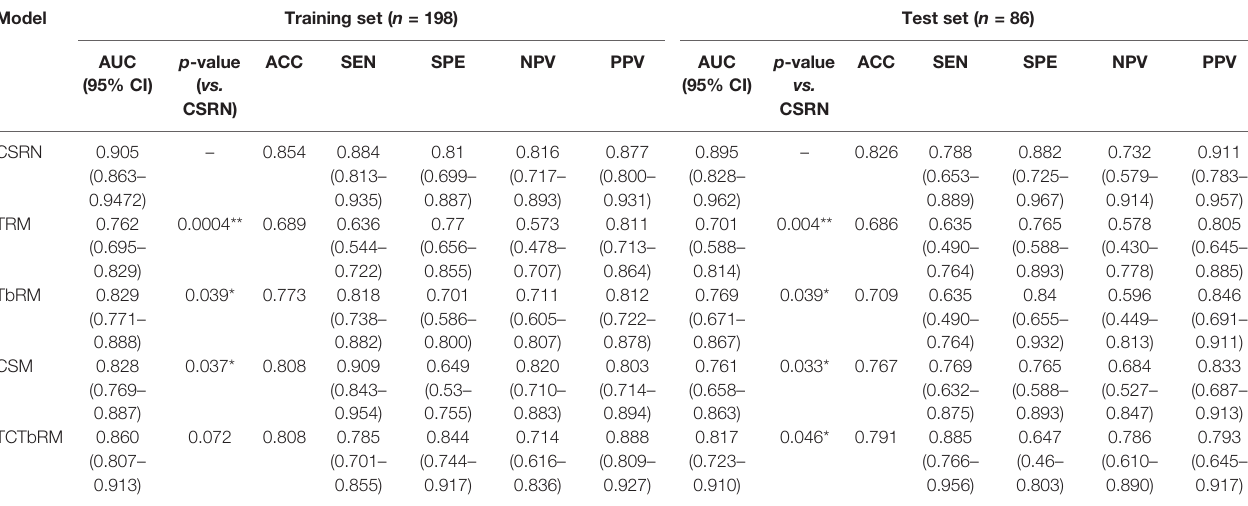
TABLE 5 | Comparison of the performance of the models.